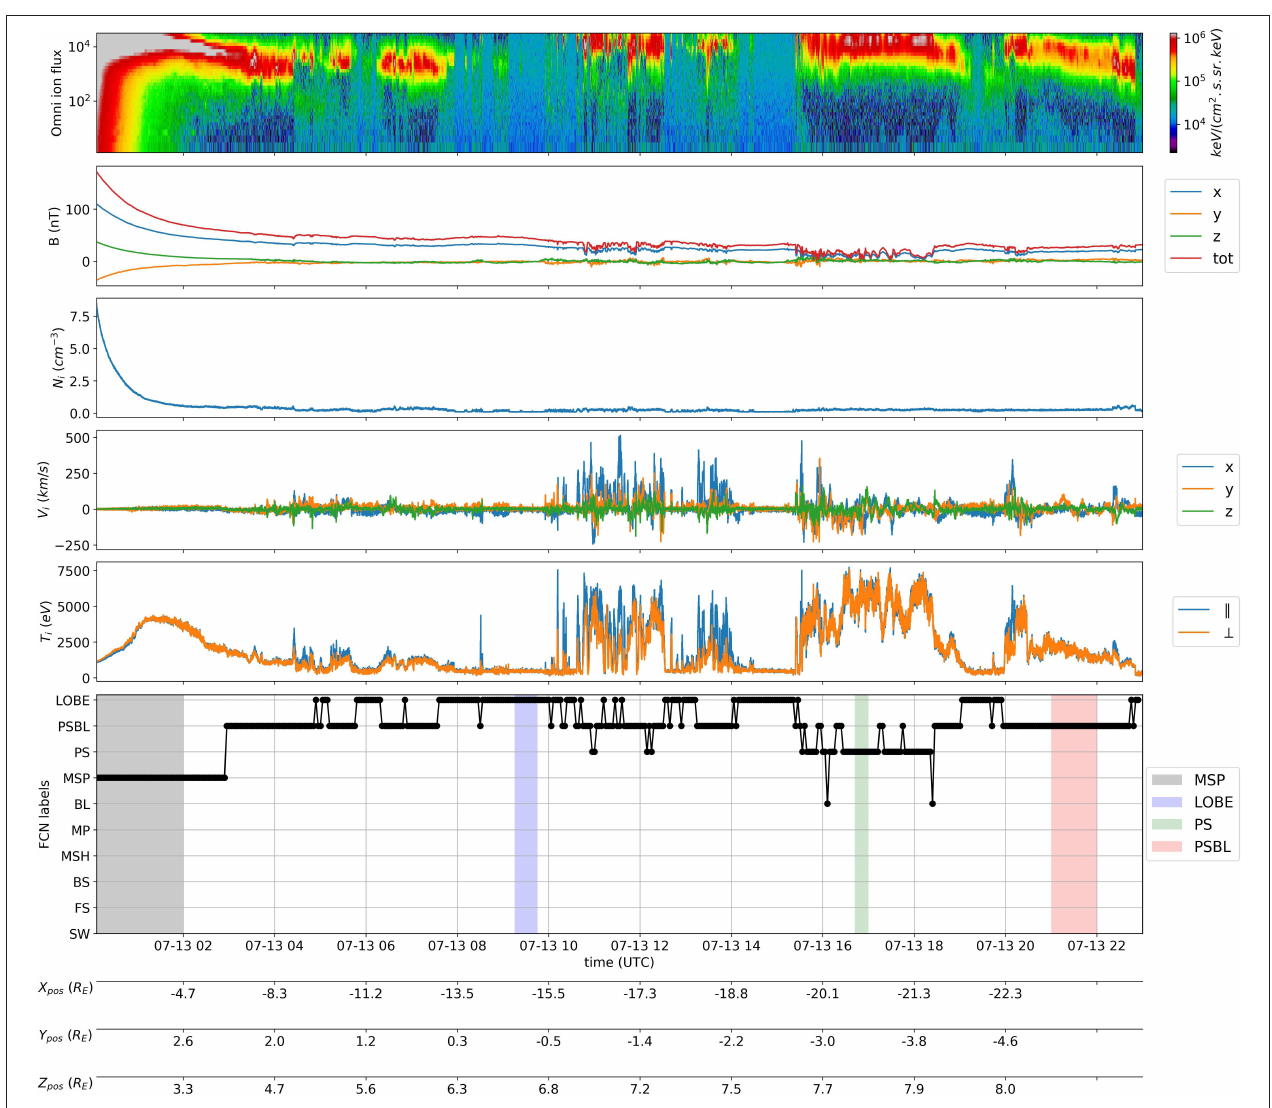
FIGURE 4 | Example of MMS nightside classification. Labels, not present in the initial data set, have been manually added to compare the FCN predictions with a ground truth. They are represented by colored regions on the FCN labels